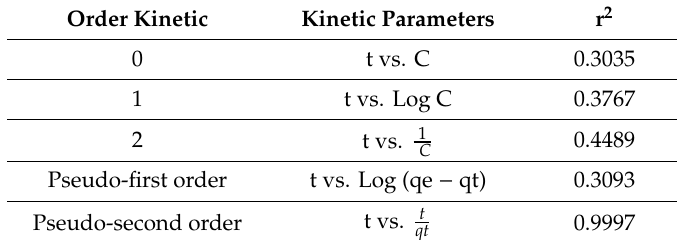
Table 2. Kinetic orders applied to the biosorption process, r 2 , and kinetic parameters.